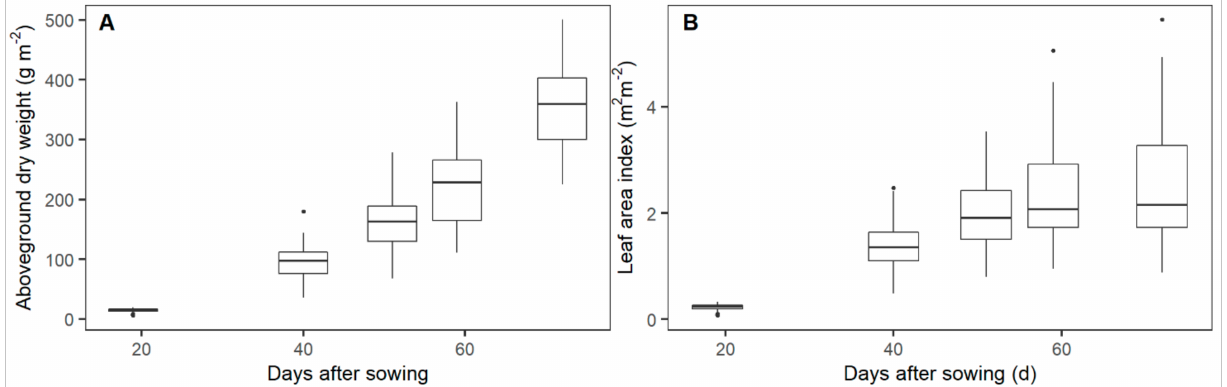
Figure 2. Dynamic changes of aboveground dry weight ( A ) and leaf area index ( B ) before wheat flowering.